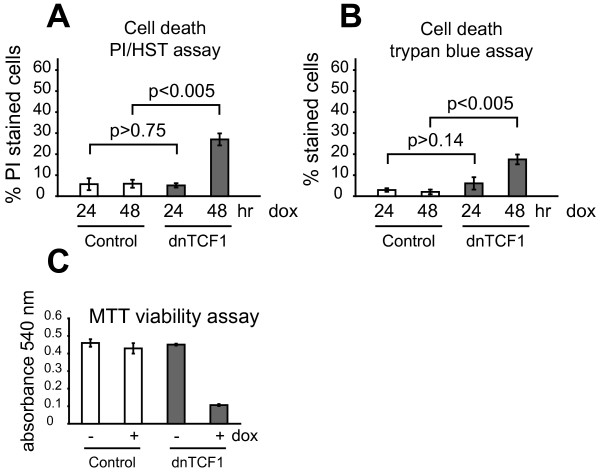
Over-expression of dnTCF1 lead to reduced viability and increased cell death rate in LS174T cells. Over-expression of dnTCF1 significantly increases the rate of cell death in LS174T cells 48 hr after induction (p < 0.005, student's t-test). This was determined using two cell death assays based on either trypan blue dye or DNA-intercalating dyes, propidium iodide (PI) and hoechst 342 (HST). LS174T control and dnTCF1 cell lines were cultured in the presence of induction. After 24 hr and 48 hr, floating and attached cells were stained with the respective dyes. Data from both assays are presented as the mean ± standard deviation from 3 separate experiments. (A) PI/HST assay: Cells were stained with PI (stains apoptotic/necrotic cells) and HST (stains viable cells). Percentage of PI stained cells relative to total cell number reflect the extent of cell death. (B) Trypan blue dye exclusion assay: Cells were stained with the trypan blue dye. Percentage of trypan blue stained cells (stains dead cells) relative to total cell number reflect extent of cell death. (C) MTT viability assay: The cells' capability to metabollically convert the MTT substrate was quantified, 48 hr after either induction (+dox) or no induction (-dox), by solubilizing MTT formazan crystals and performing spectrophotometry at 540 nm. Cell viability, which is proportional to the absorbance at 540 nm, decreases in dnTCF1 over-expressing LS174T cells relative to control cells.